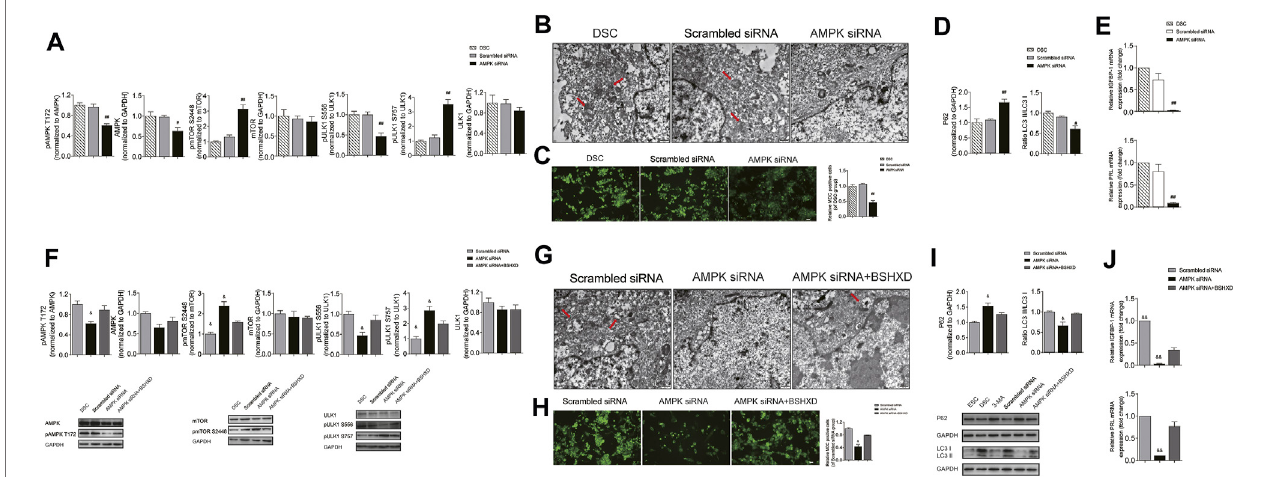
FIGURE6| BSHXDimproveddecidualizationbyinterveningautophagyviaAMPK/mTOR/ULK1inDSCs. (A) TheexpressionlevelsofpAMPK,pmTORandpULK1 intheDSC,ScrambledsiRNAandAMPKsiRNAgroupusedbyWesternblot; (B) TheautophagosomesintheDSC,ScrambledsiRNAandAMPKsiRNAgroupobserved by TEM (scale bar: 500 nm); (C) The autophagy level in the DSC, Scrambled siRNA and AMPK siRNA group observed by MDC assay (scale bar: 50 μ m); (D) The expression levels of LC3II/LC3I and p62 in the DSC, Scrambled siRNA and AMPK siRNA group used by Western blot; (E) mRNA of IGFBP1 and PRL in the DSC, ScrambledsiRNAandAMPKsiRNAgroup; (F) TheexpressionlevelsofpAMPK,pmTORandpULK1intheScrambledsiRNA,AMPKsiRNAandAMPKsiRNA+BSHXD groupusedbyWesternblot; (G) TheautophagosomesintheScrambled siRNA,AMPKsiRNA andAMPKsiRNA+BSHXDgroupobservedbyTEM(scalebar:500